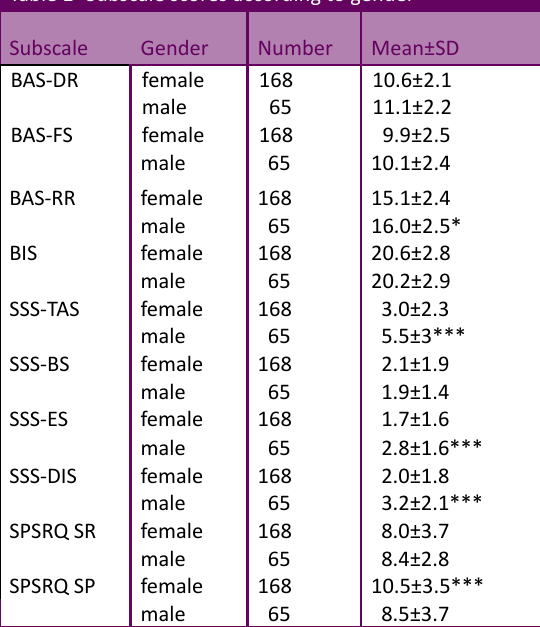
Table 1- Subscale scores according to